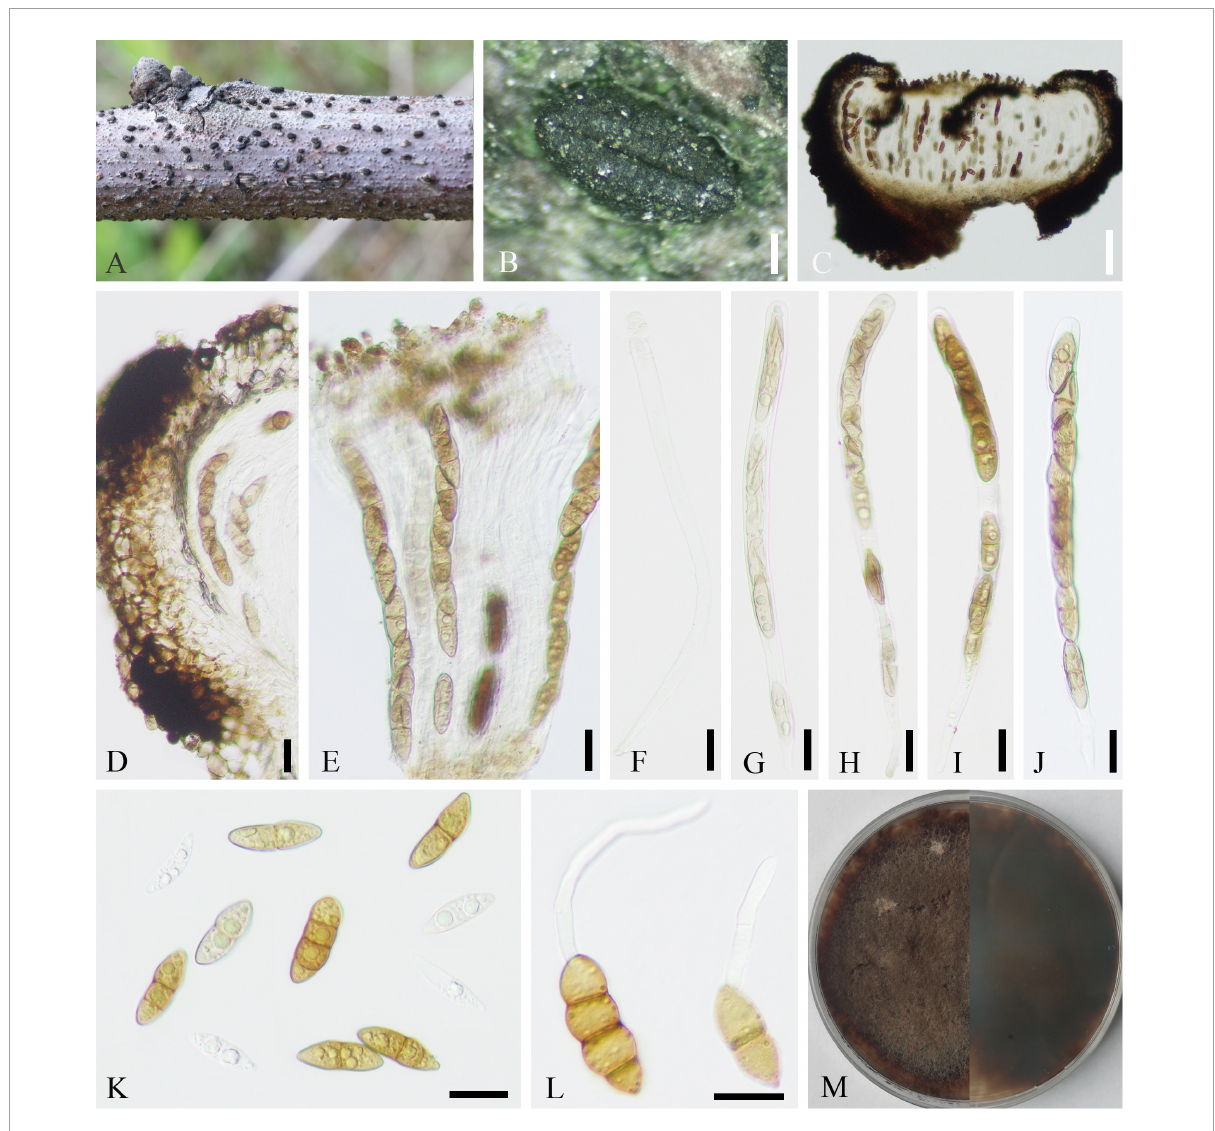
FIGURE10 Rhytidhysteron subrufulum (SICAU 22-0091). (A,B) Ascomata on host substrate. (C) Vertical section of ascoma. (D) Exciple. (E) Pseudoparaphyses and asci. (F–J) Asci. (K) Ascospores. (L) Germinating ascospores. (M) Colony on PDA for 90 days. Scale bars: (B) 200 µ m, (C) 100 µ m, and (D–L) 20 µ m.